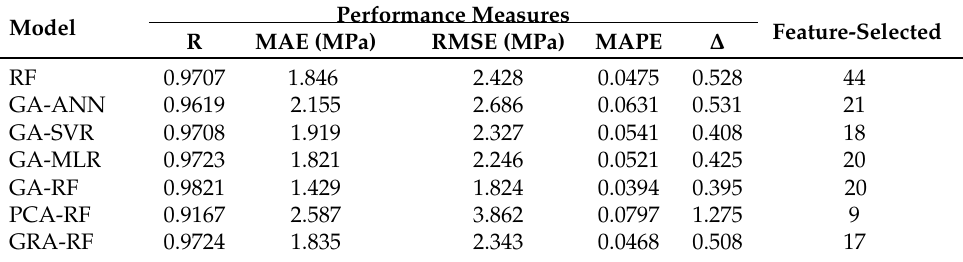
Table 6. Predictive performance of different model on the testing set.